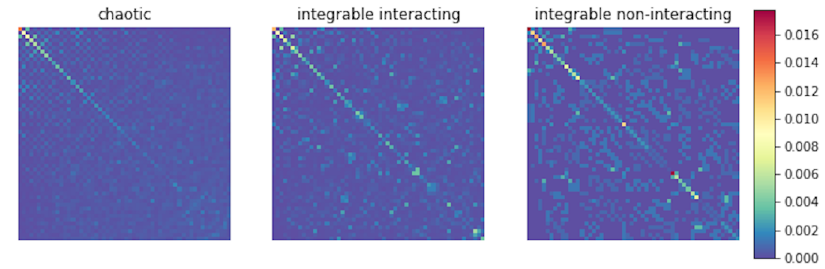
Figure 27 . ECH matrices of the mixed-field Ising models of length N = 9 at the free, integrable interacting, and maximally chaotic points, with k = 2 -local operators taken as